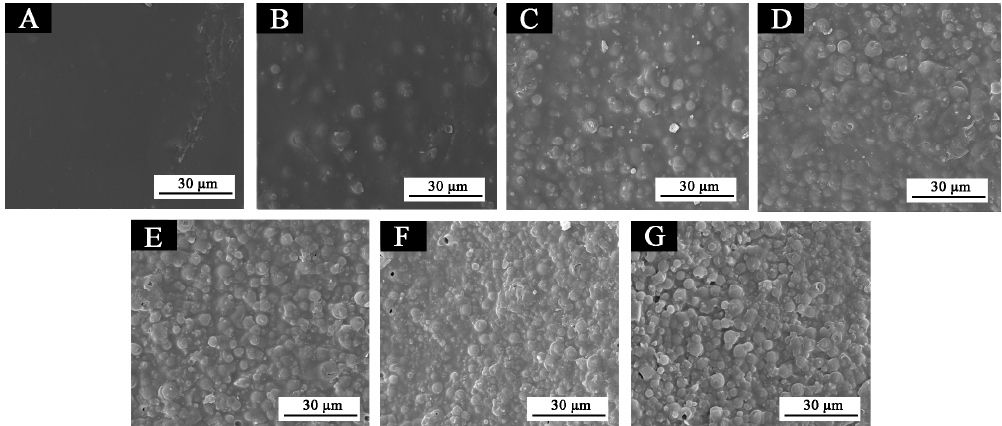
Figure 13. SEM of primer film containing different concentrations of thermochromic microcapsules: ( A ) 0%; ( B ) 5.0%; ( C ) 10.0%; ( D ) 15.0%; ( E ) 20.0%; ( F ) 25.0%; ( G ) 30.0%.